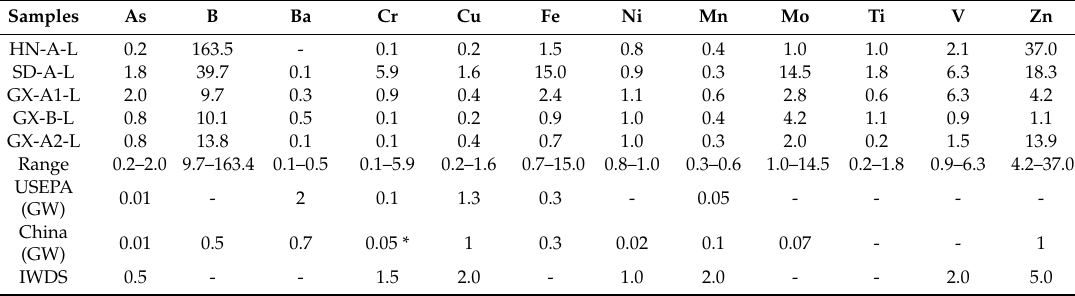
Table 7. The concentration of minor elements (ions) in red mud leachate (unit: mg / L). Samples As